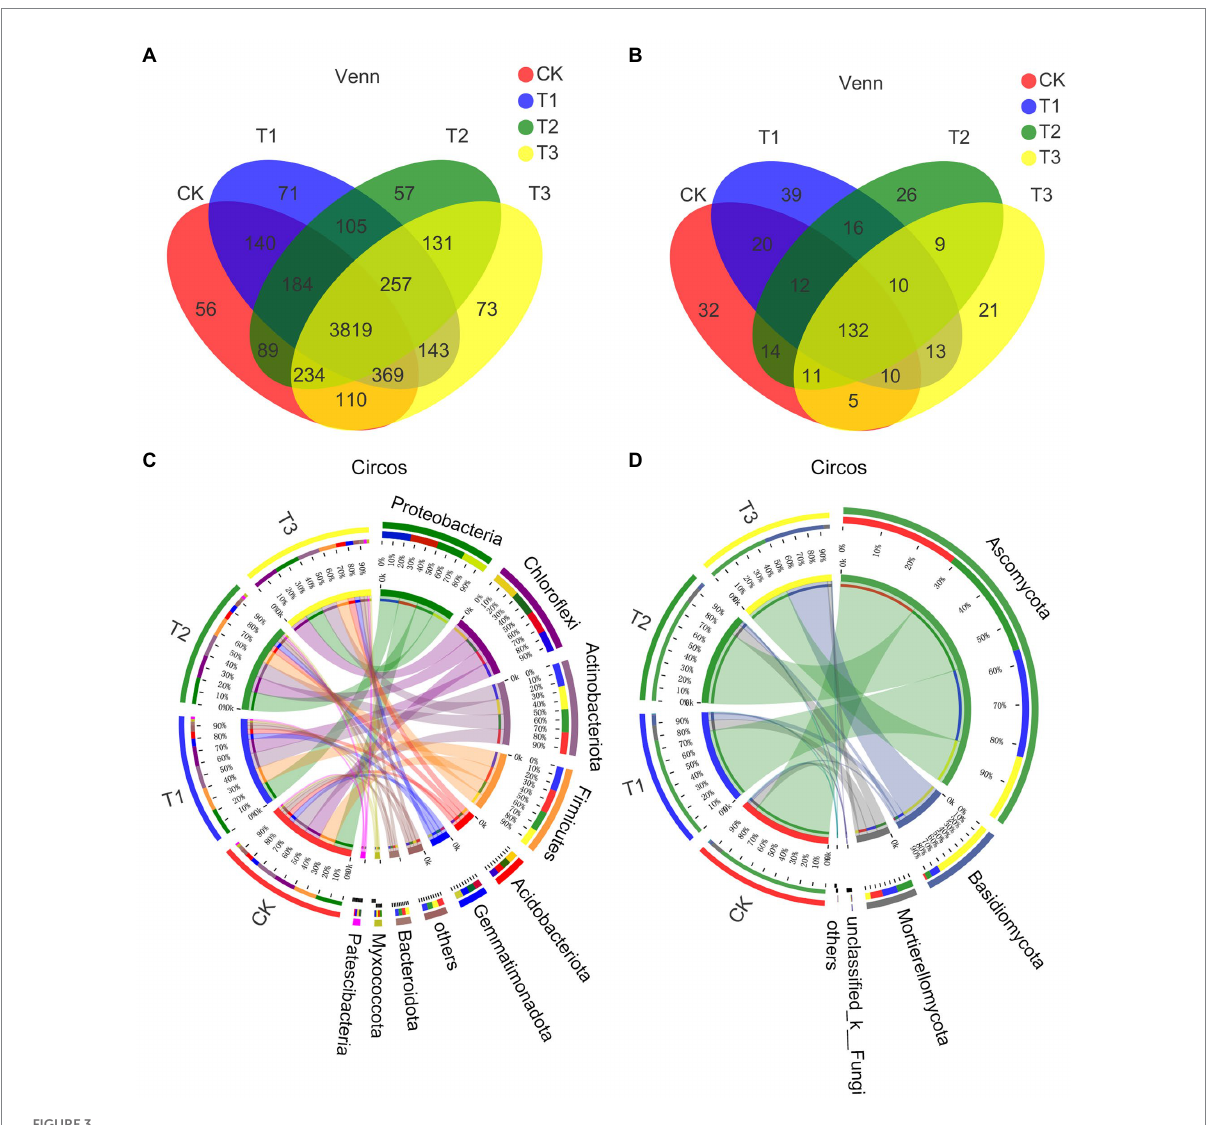
FIGURE 3 The effect of different irrigation amounts on the similarity and overlap of bacterial (A) and fungal (B) OTU compositions in soil; the similarity level was higher than 97% (Venn). Circos reflects the distribution ratio of dominant phyla in different treatments and the distribution ratio of each dominant phylum in different treatments, including bacteria (C) and fungi (D) . n =